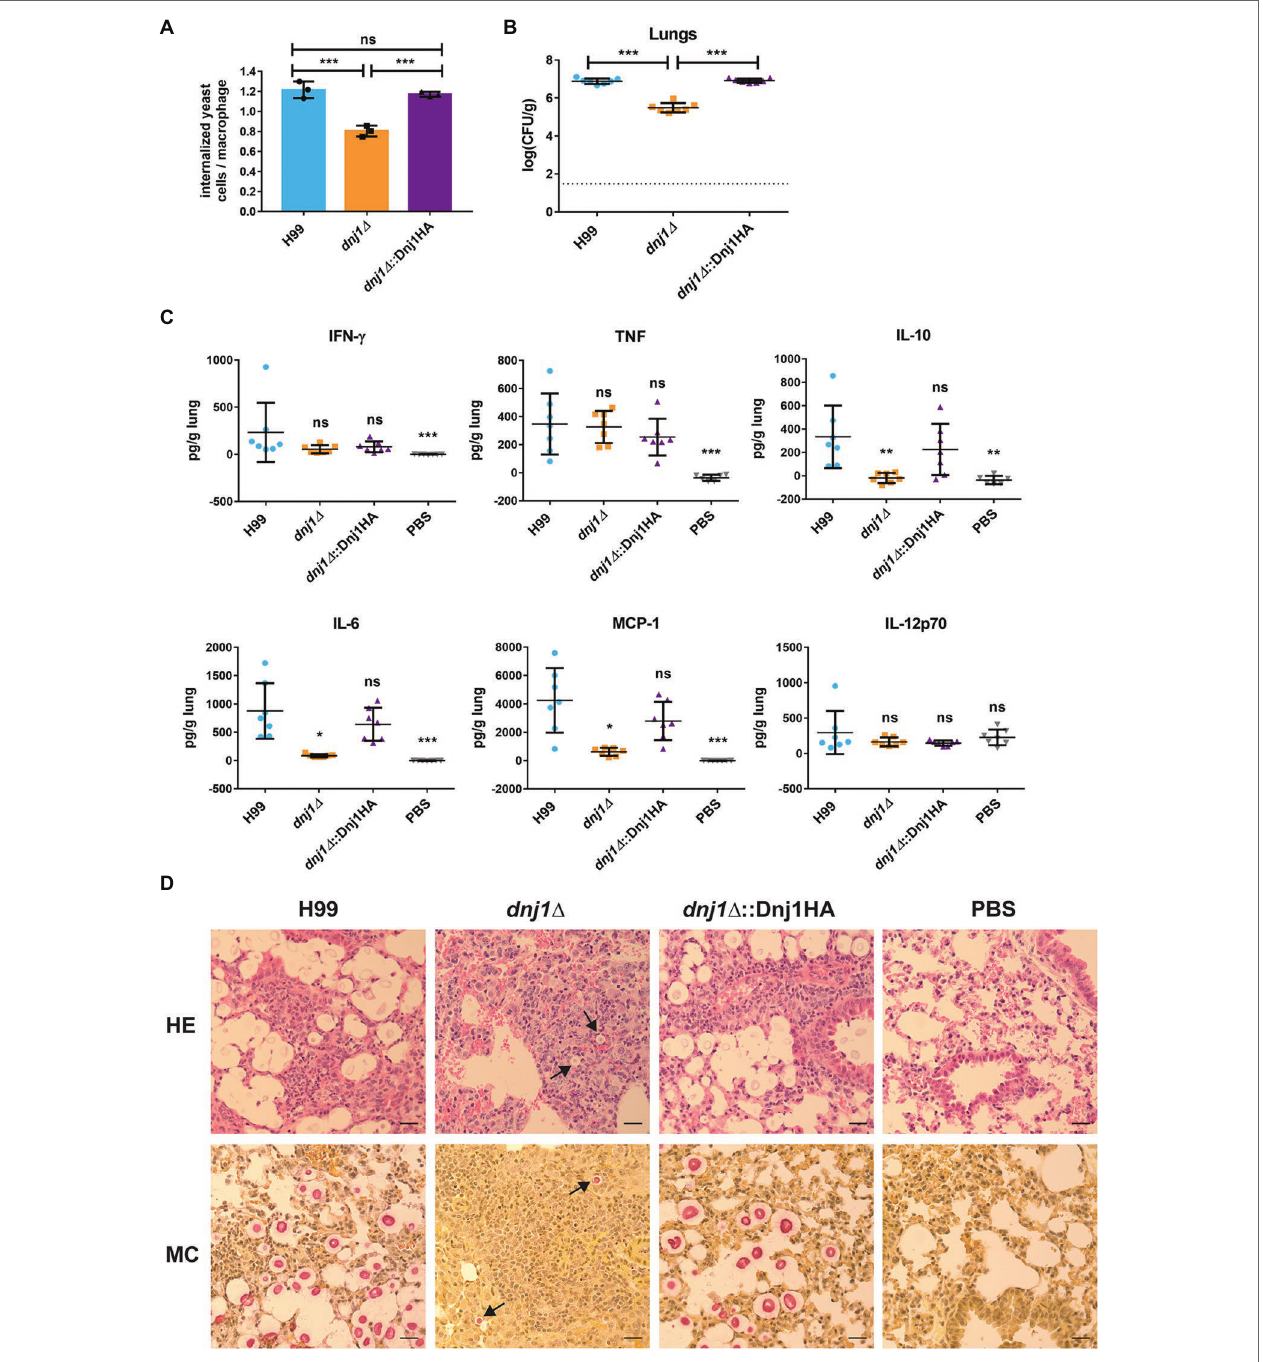
FIGURE 9 | The attenuated virulence of the dnj1 ∆ mutant may be attributed to decreased uptake by macrophages, an altered immune response, and slower proliferation early in a mouse model of cryptococcosis. (A) The proportion of internalized C. neoformans cells per macrophage for J774.A1 murine macrophages infected with the wild type (H99), dnj1 ∆ mutant, and the dnj1 ∆ ::Dnj1HA complement. Significance was determined by a one-way ANOVA with Tukey’s multiple comparisons. (B) The fungal burdens in the lungs collected 6 days post infection were also determined and statistical significance was determined by Mann-Whitney U tests. The dashed line indicates the limit of detection for CFU determination. (C) The cytokine profiles in the lungs of mice infected with wild type (H99), dnj1 ∆ mutant, dnj1 ∆ ::Dnj1HA complement, or mock infected (PBS), were determined using a cytometric bead array mouse inflammation kit at 6 days post infection. All significance shown was determined using one-way ANOVAs with Tukey’s multiple comparisons and the differences are relative to the wild type (H99) infection (ns, not significant; * p < 0.05, ** p < 0.01 and *** p < 0.005). (D) Histology micrographs of mouse lungs collected 6 days after inoculation with each strain stained with hematoxylin and eosin (HE) or mucicarmine (MC). Arrows indicate C. neoformans in the dnj1 ∆ mutant. Images are representative of lung histology from three mice. Scale bar = 25 μ